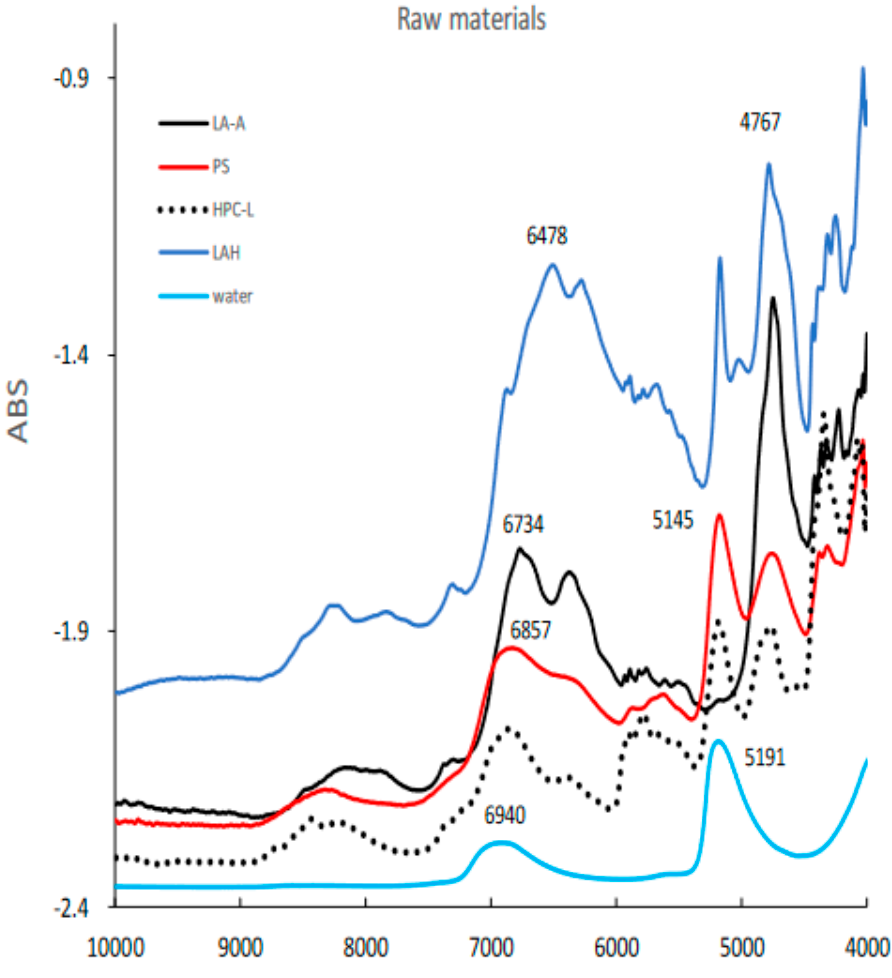
Figure 3. The NIR spectra of raw powder materials for HSWG. LAA, α -lactose anhydride; LAH, α -lactose monohydrate; PS, potato starch; HPC-L; hydroxypropyl cellulose.